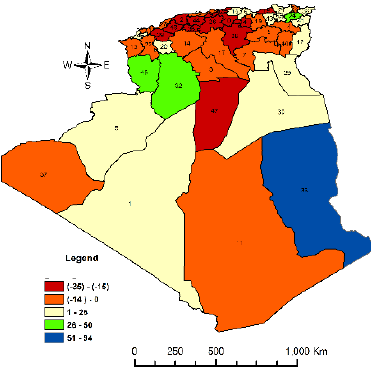
Figure 8. The most provinces affected by security crisis in